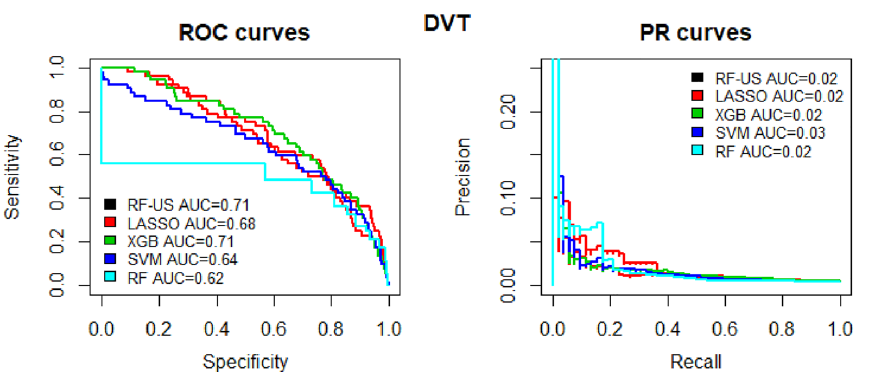
Figure 2. ROC curves for the various models that were assessed for DVT.